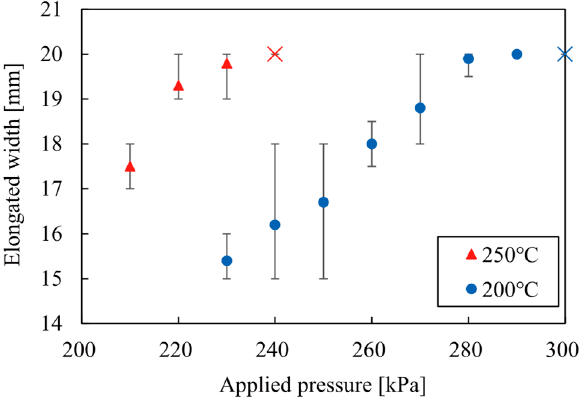
Figure 11. Relationship between the molded width, temperature, and applied pressure.